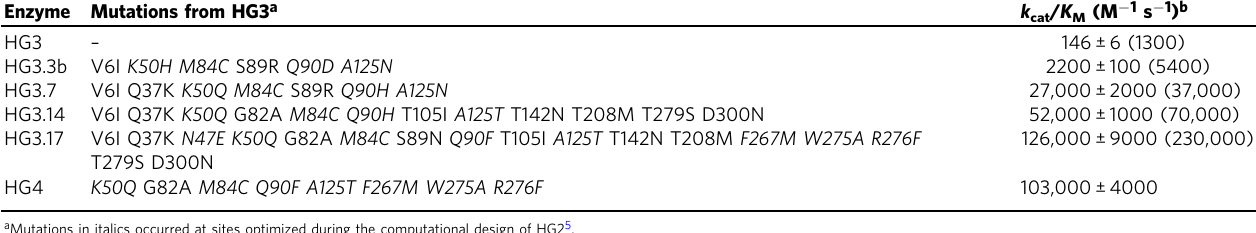
Table 1 Kinetic parameters of Kemp eliminases. Enzyme Mutations from HG3